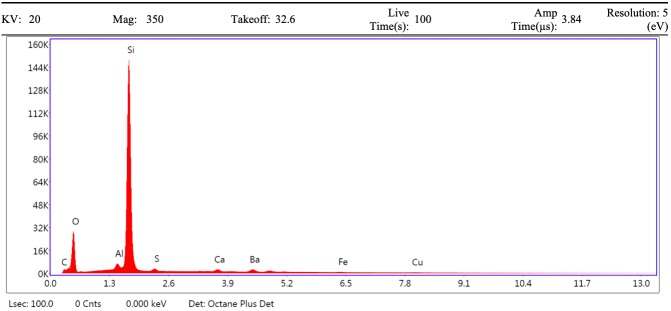
EDS spectrum of vessel from demineralised Late Cretaceous Centrosaurus bone area C.